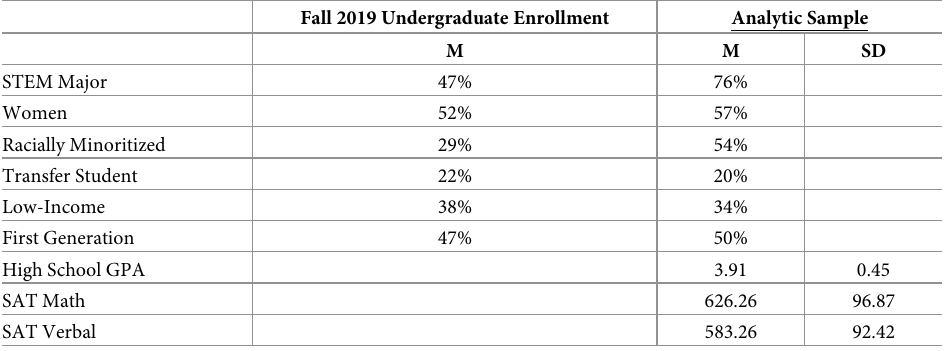
Table 1. Generalizability